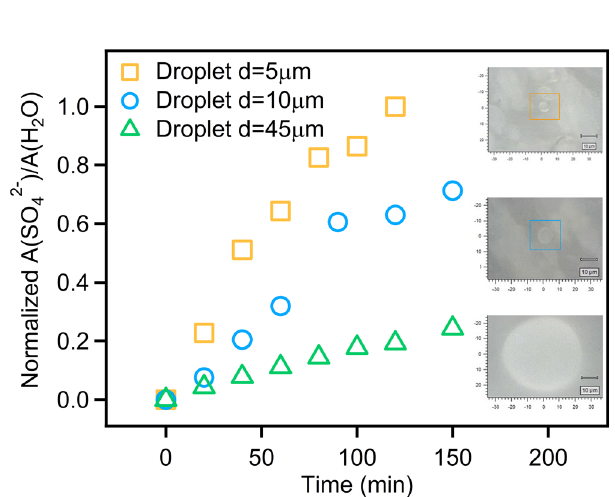
Fig. 2 Raman peak area ratio of sulfate to water as a function of reaction time, as well as microscope images of droplets. Relationships between sulfate area ratio and droplet diameter, as well as ×50 optical microscope images of droplets. A represents Raman peak area, and d represents diameter. All of these experiments were performed at 298 K, 85% relative humidity (RH), and 327 ppbv SO 2